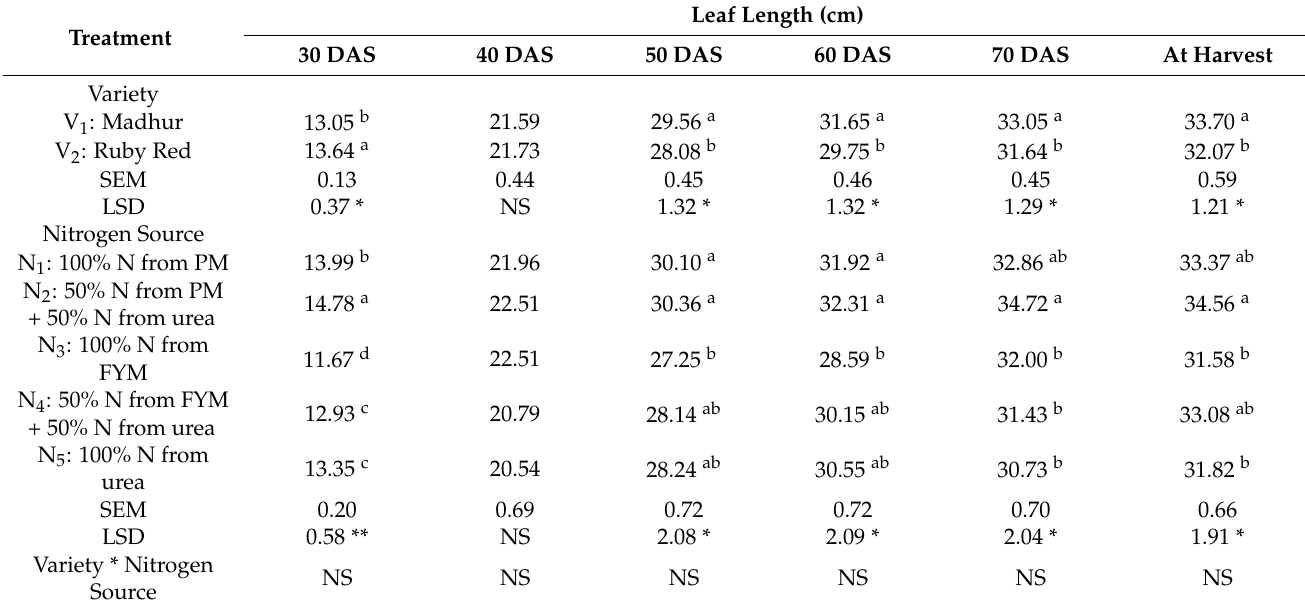
Table 4. Effect of variety and nitrogen source on leaf length of beetroot at different stages at AFU, Rampur, Chitwan in 2018/19.